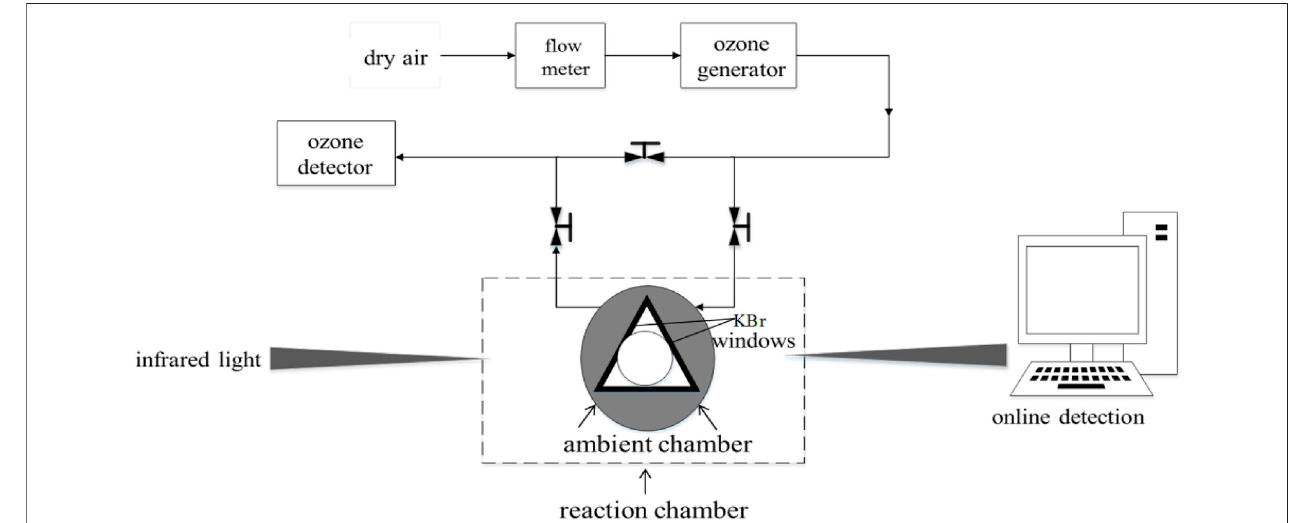
FIGURE 1 | in-situ FTIR experimental setup.